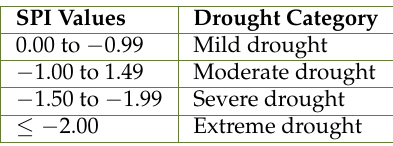
Table 2. Classification of SPI values and corresponding drought level. Source: McKee et al.